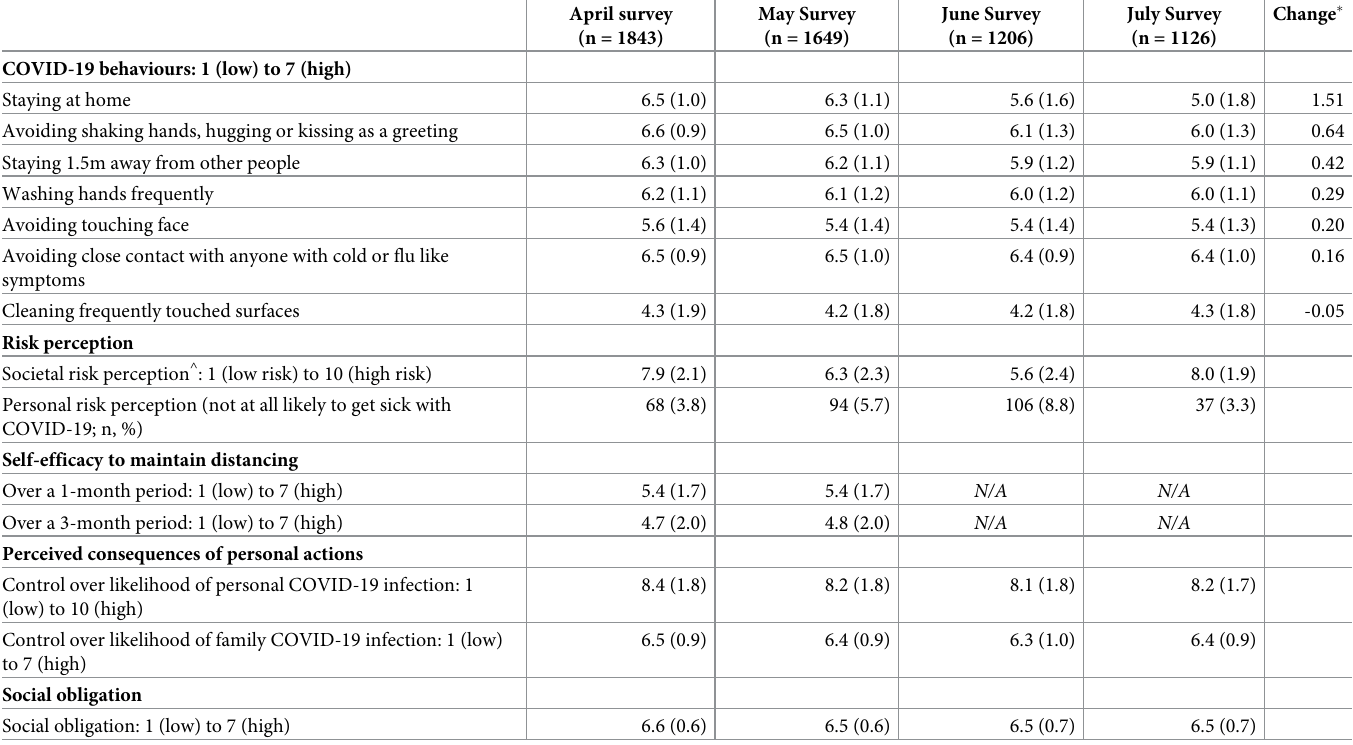
Table 3. Descriptive statistics of individual COVID-19 protection behaviours and relevant psychosocial factors, across four survey